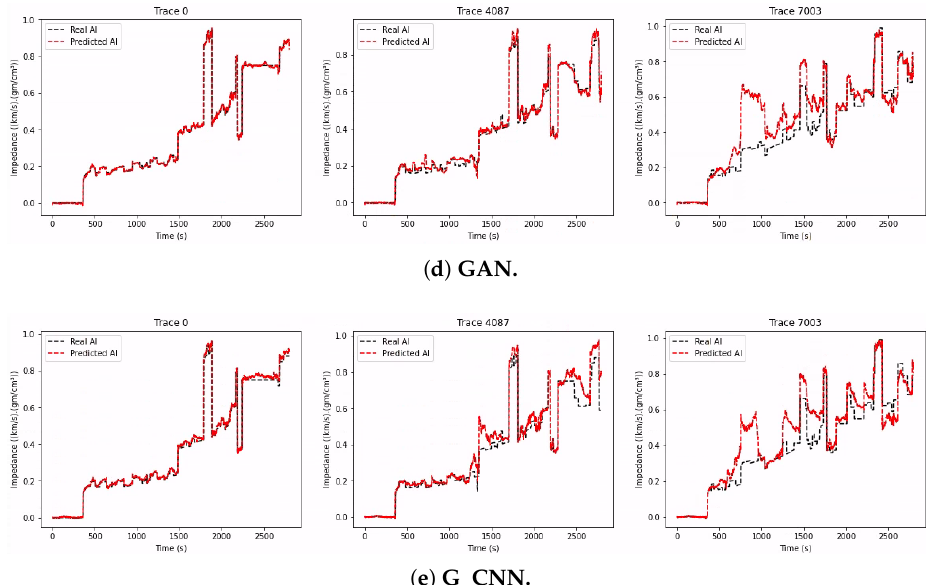
Figure 10. Prediction results for three seismic trace tests from the Marmousi2 dataset (without noisy data).